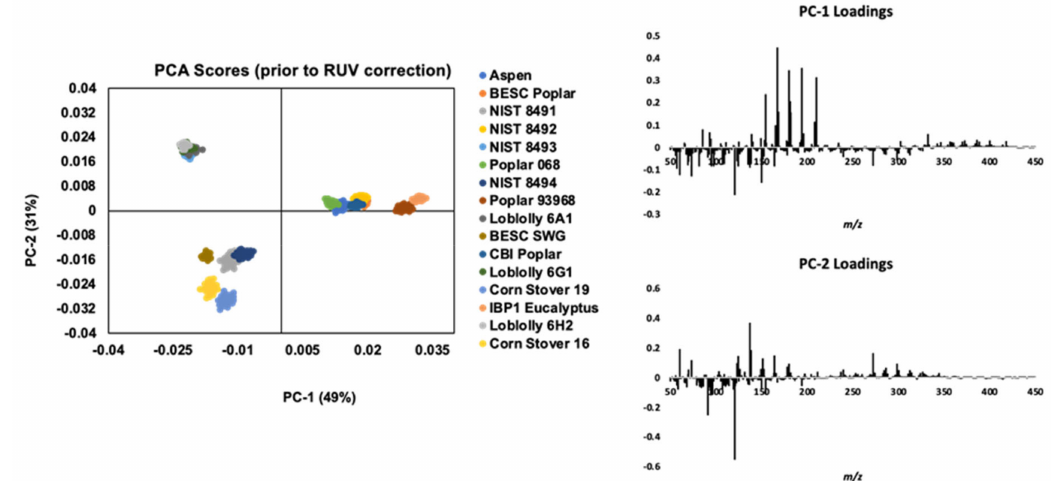
Figure 1. Principal component analysis of pyrolysis followed by mass spectrometry such as molecular beam mass spectrom- etry (py-MBMS) data from different types of lignocellulosic